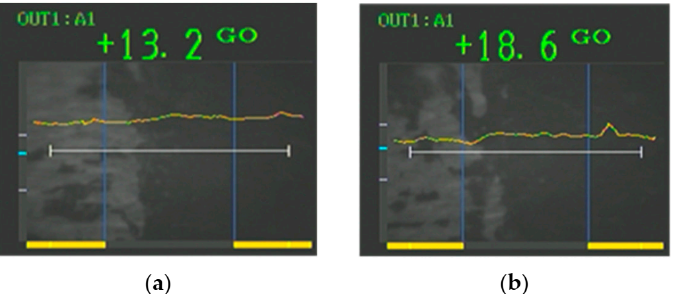
Figure 20. Coating thickness at the top and bottom of the sample: ( a ) top 13.2 µ m; ( b ) bottom 18.6 µ m. The black part on the right is the coating film, and the gray part on the left is the part where the coating film is peeled off. The numerical value at the top is the coating thickness at the center of the screen. The coating thickness was about 6–9 µ m, and the thinnest part was 5.8 µ m. (See Figure 19). In order to confirm the variation in coating thickness, the coating thickness at the top and bottom of the sample was also measured. The coating thickness was about 13–19 µ m, and although there was a large variation, it could be seen that the coating was thicker than the central part (see Figure